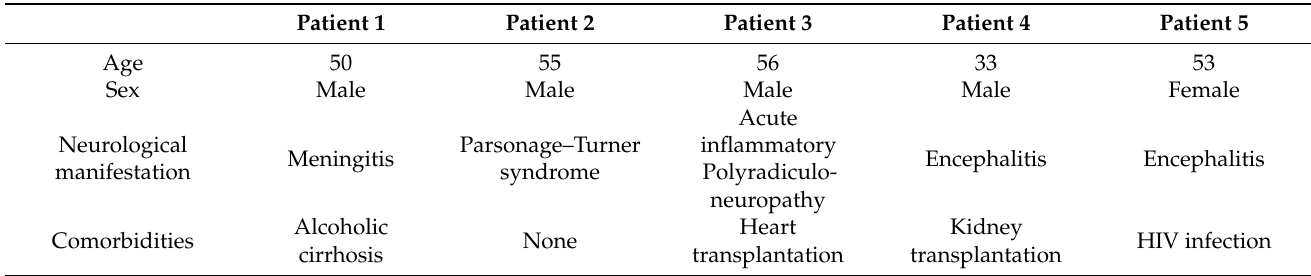
Table 1. Patients’